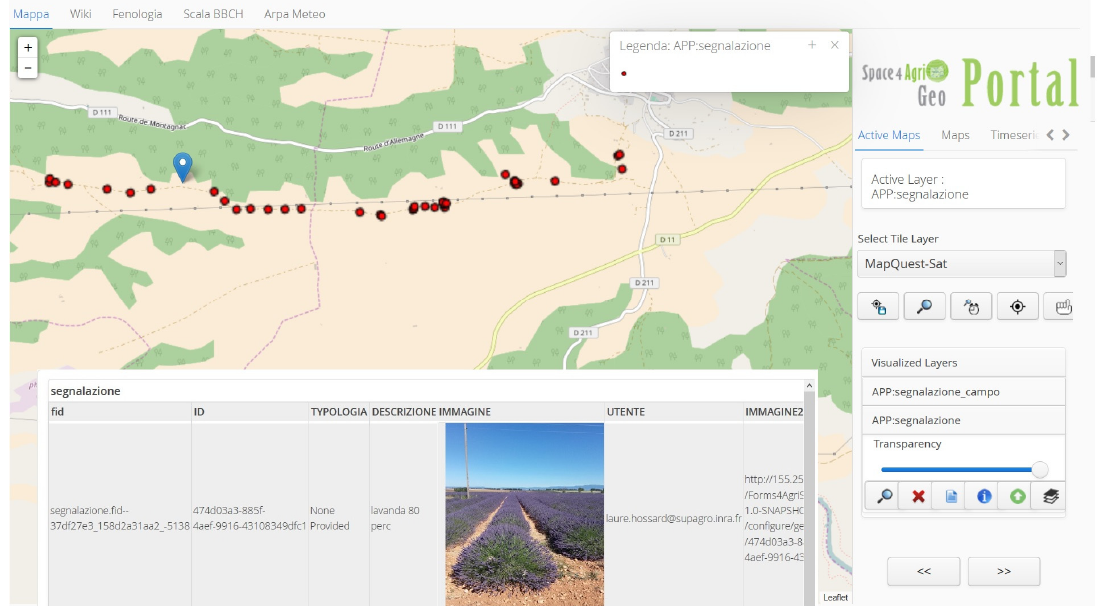
Figure 5. S4A geoportal displaying VGI items (red points) containing pictures taken from fields in Provence, France, during summer 2016 campaign. The pictures are mostly located on the country roads crossing an agronomic area cultivated with lavender and thus one does not know which parcel they annotate.